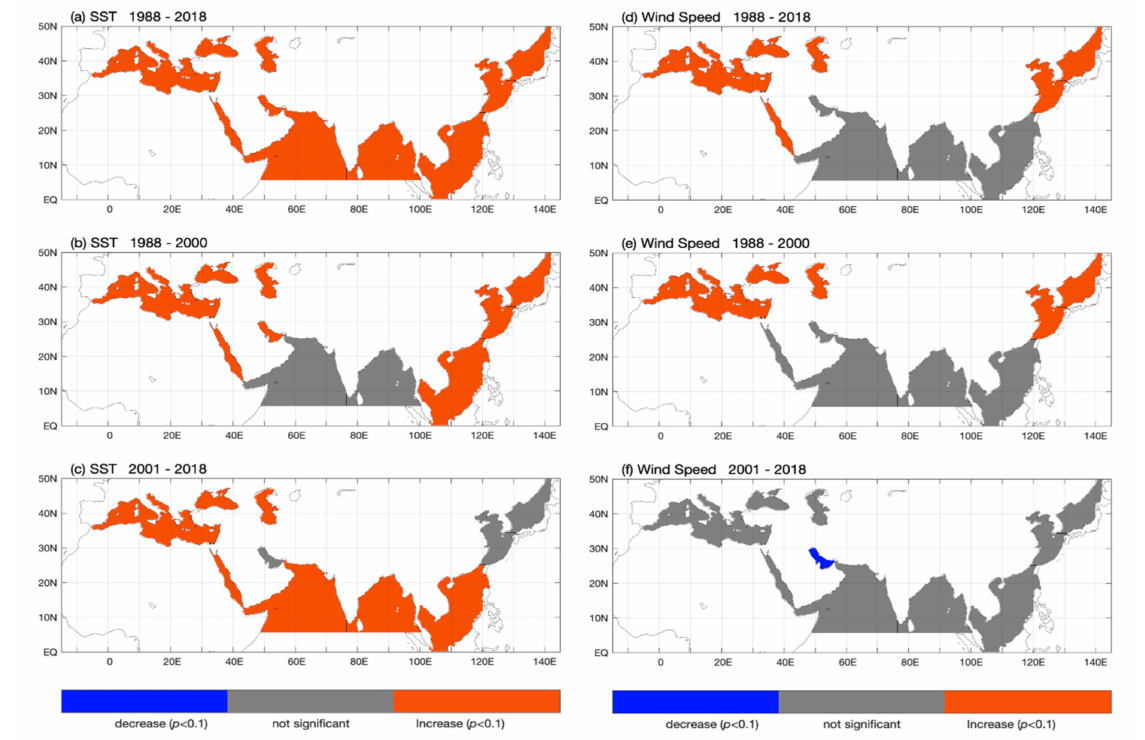
Figure 16. Schematic depiction of the decadal changes in annual-mean winds averaged over each of the 10 marginal seas for SST (left) and wind speed (right) in three periods: ( a , d ): 1988–2018; ( b , e ): 1988–2000; ( c , f ): 2001–2018. Areas colored in red (blue) denote that the rate of increase (reduction) in SST and wind speeds is statistically significant at the 90% confidence interval. The areas colored in gray denote that the changes in the SST or wind speed are not